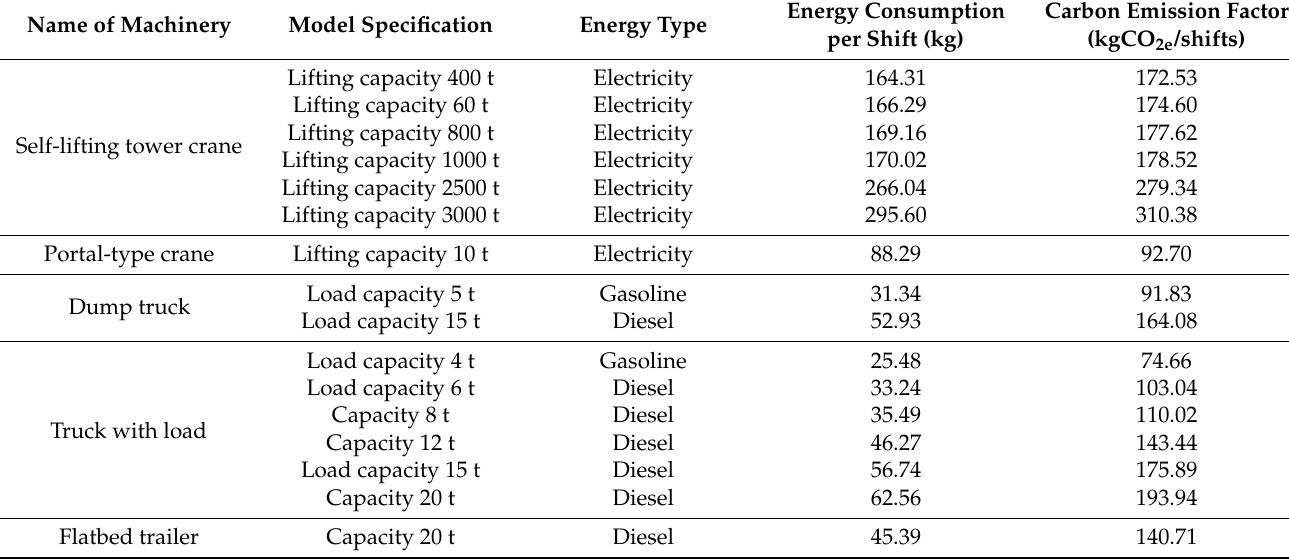
Table 5. Summary of carbon emission factors of machinery and equipment commonly used in the transportation stage of prefabricated